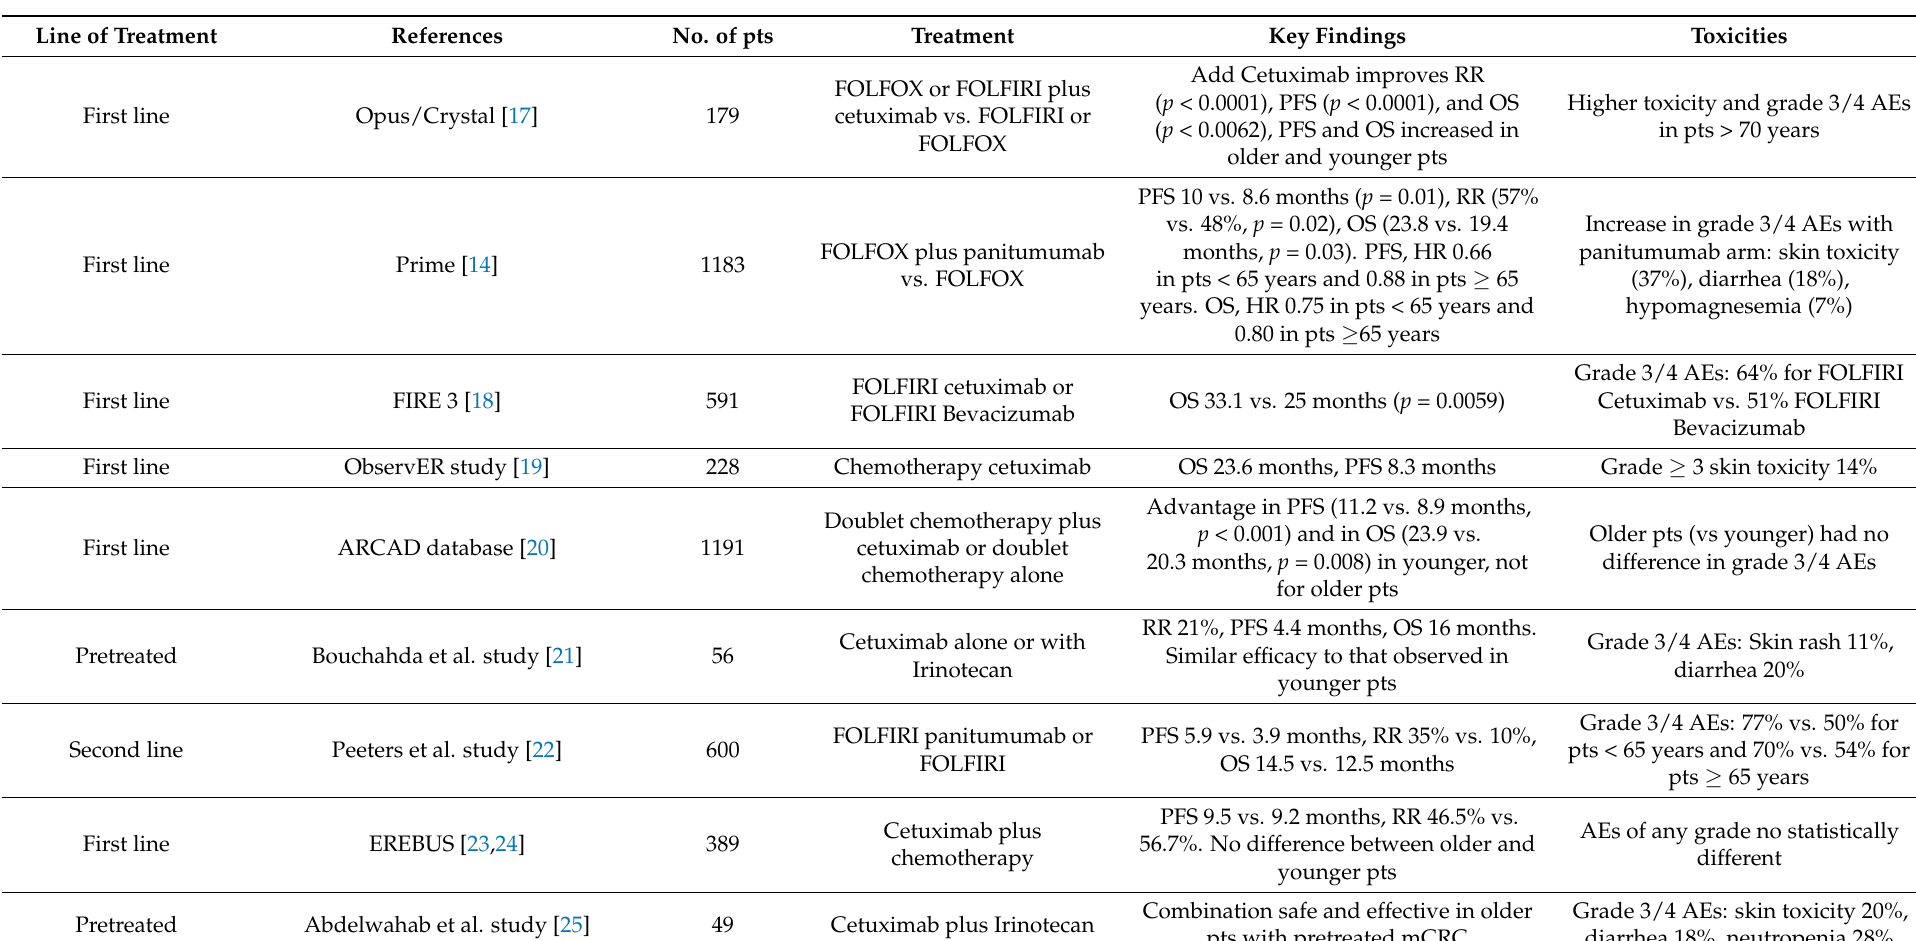
Table 1. Anti-EGFR inhibitors and fit